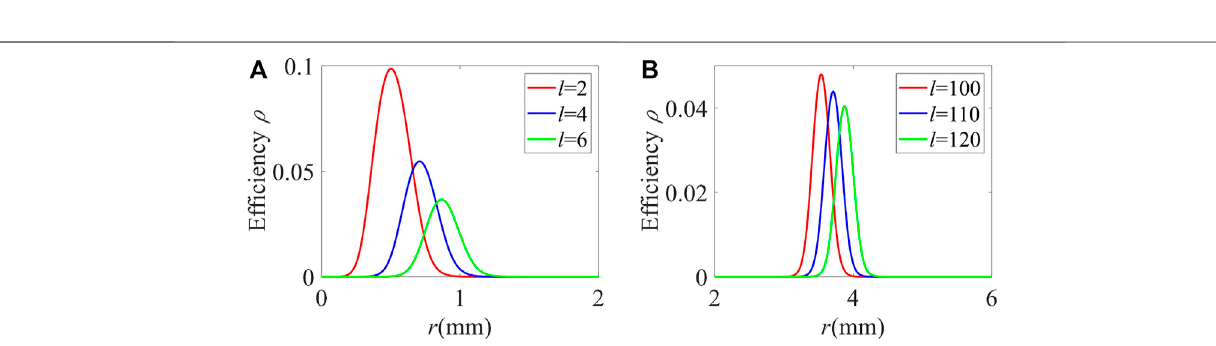
FIGURE 7 | Absorption coef fi cient difference Δ α and interference visibility η corresponding to (A) the low-order TCs and (B) high-order TCs. Other parameters are the same as in Figure 6 .